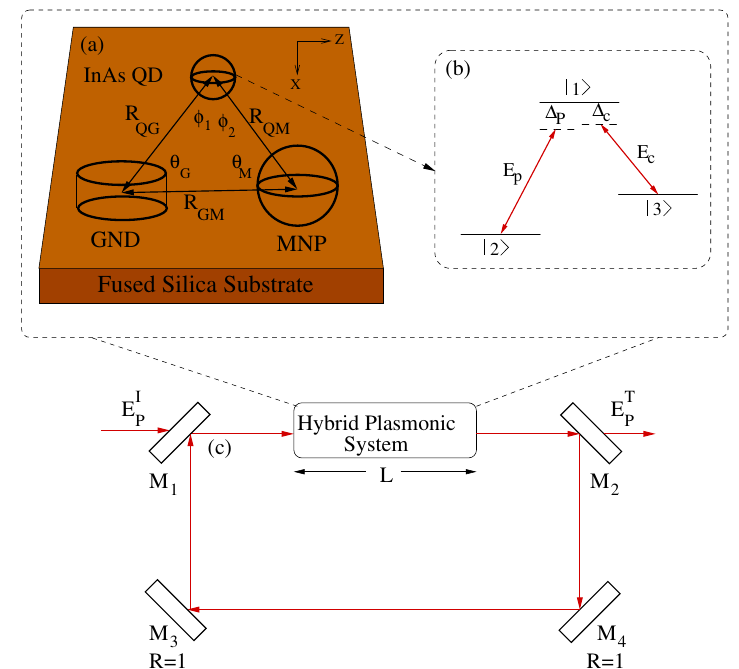
Figure 1. ( a ) The MNP–GND–QD hybrid system setup. ( b ) Λ -type atomic configuration of the QD. ( c ) Unidirectional ring optical cavity having the MNP–GND–QD hybrid system of length L . The mirrors M 3 and M 4 are perfect mirrors whereas M 1 and M 2 are partially reflecting mirrors. The incident and transmitted fields are denoted by E I p and E T p